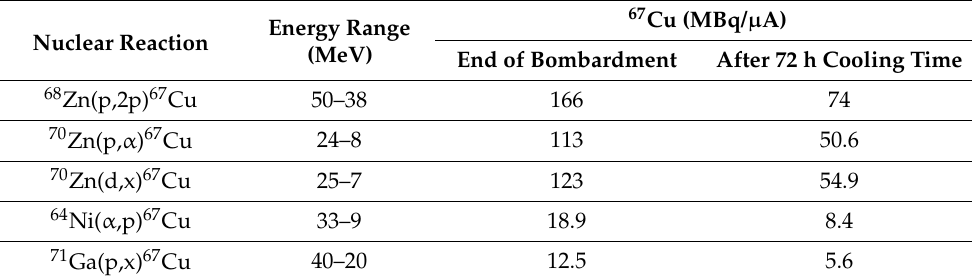
Table 5. Nuclear reactions for Copper-67 production and yields